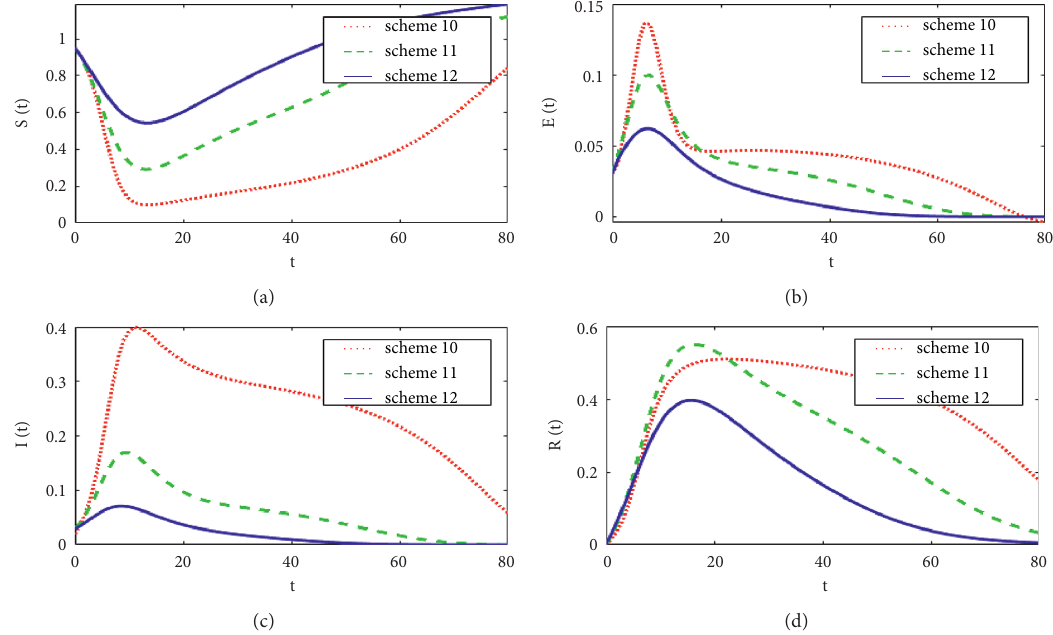
Figure 5: Curves of changes in the population density of the four categories of netizens at different values of c .